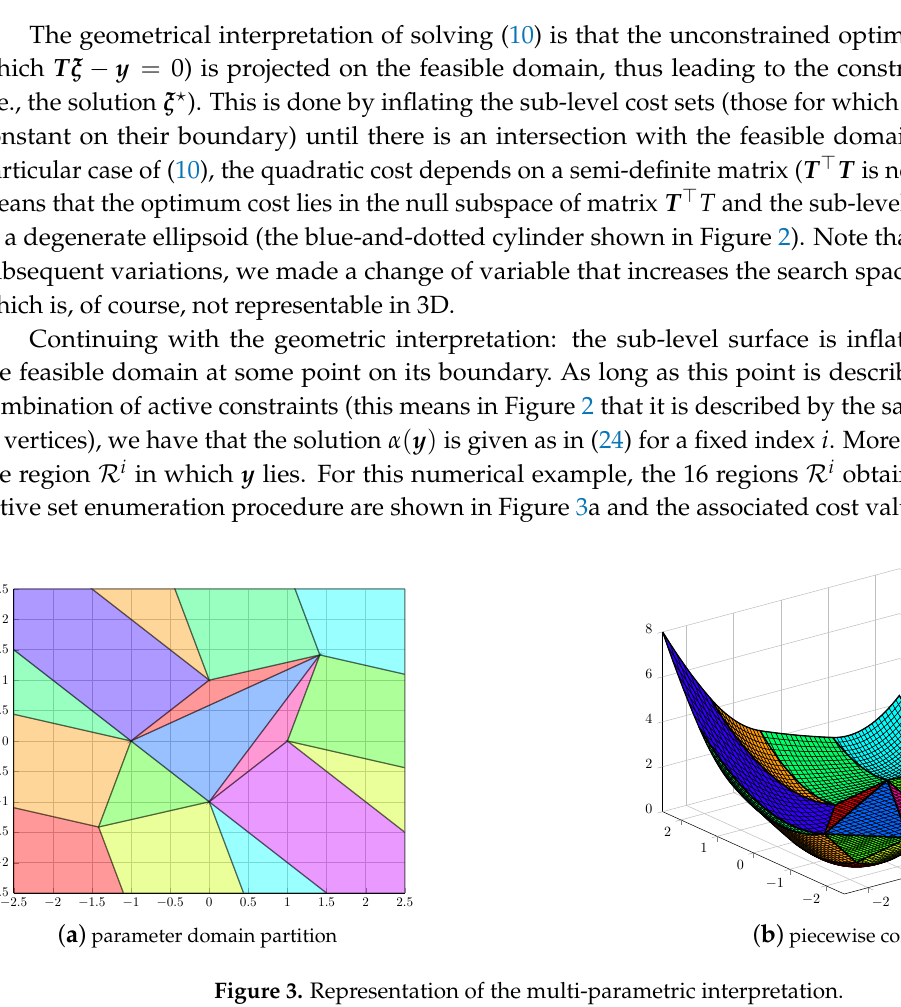
Figure 2. Feasible domain and degenerate cost surface.